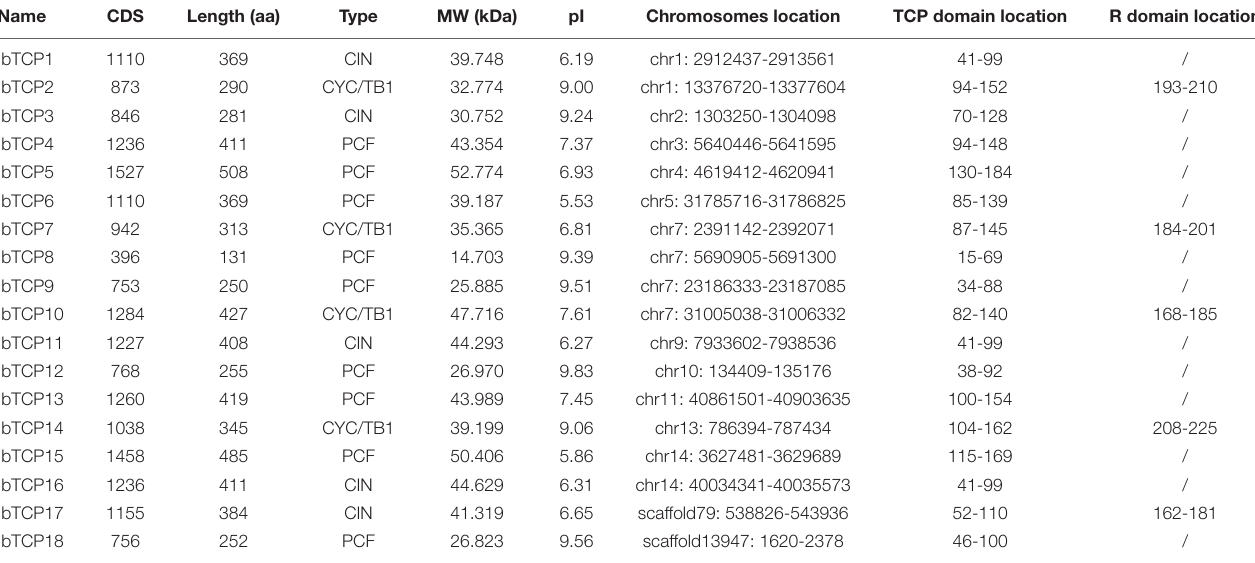
TABLE 1 | Characterization of the IbTCP family in sweet potato.